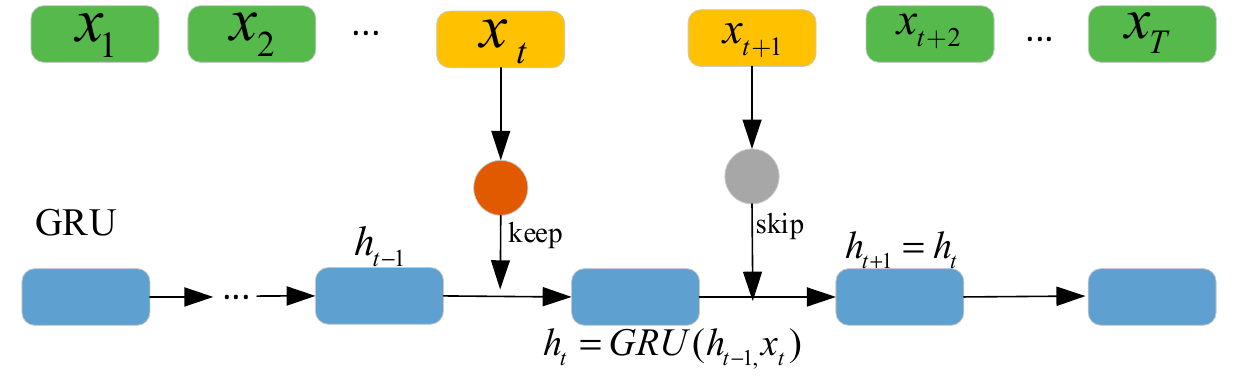
Figure 3. Skip-GRU network architecture.